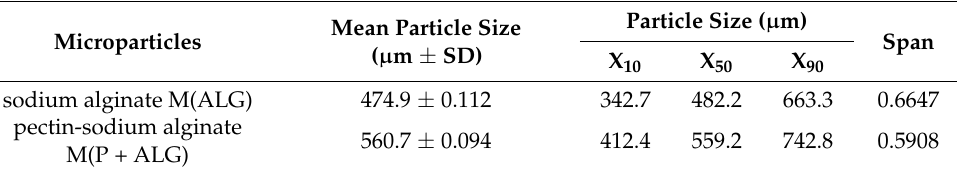
Figure 3. Particle size distribution for sodium alginate ( a ) and pectin-sodium alginate ( b ) micropar- ticles containing surfactant. Table 1. Characteristics of the prepared microparticles. X 10 , X 50 , and X 90 represent the volume percentages of particles (10%, 50%, and 90% undersize, respectively).